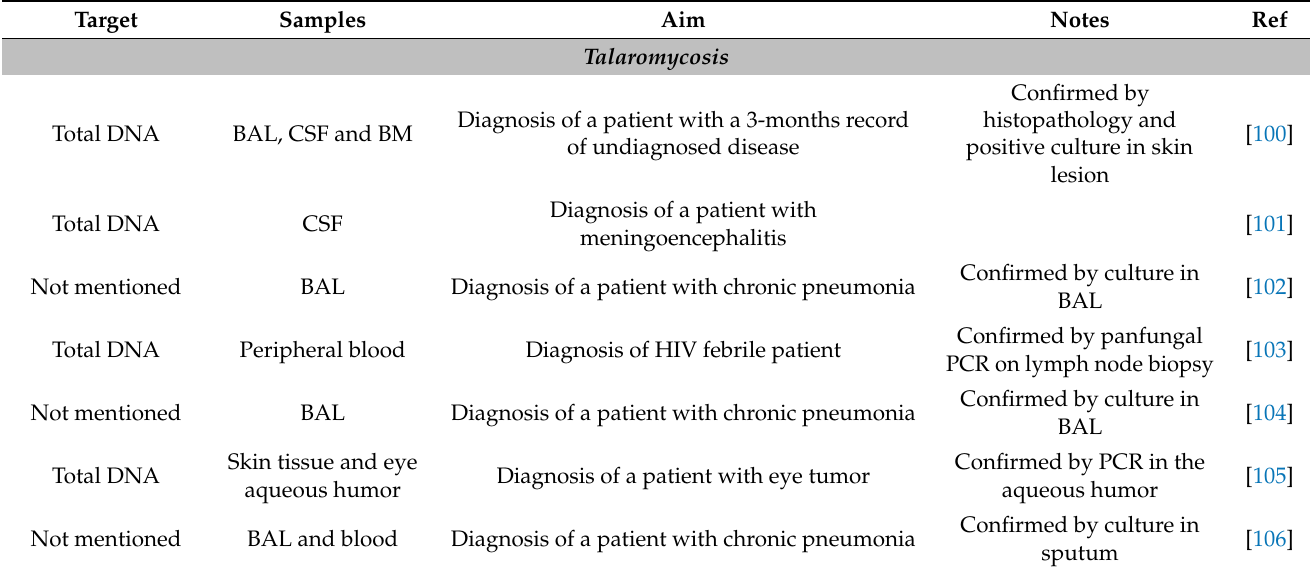
Table 3. Details of the studies where NGS was used to diagnose endemic